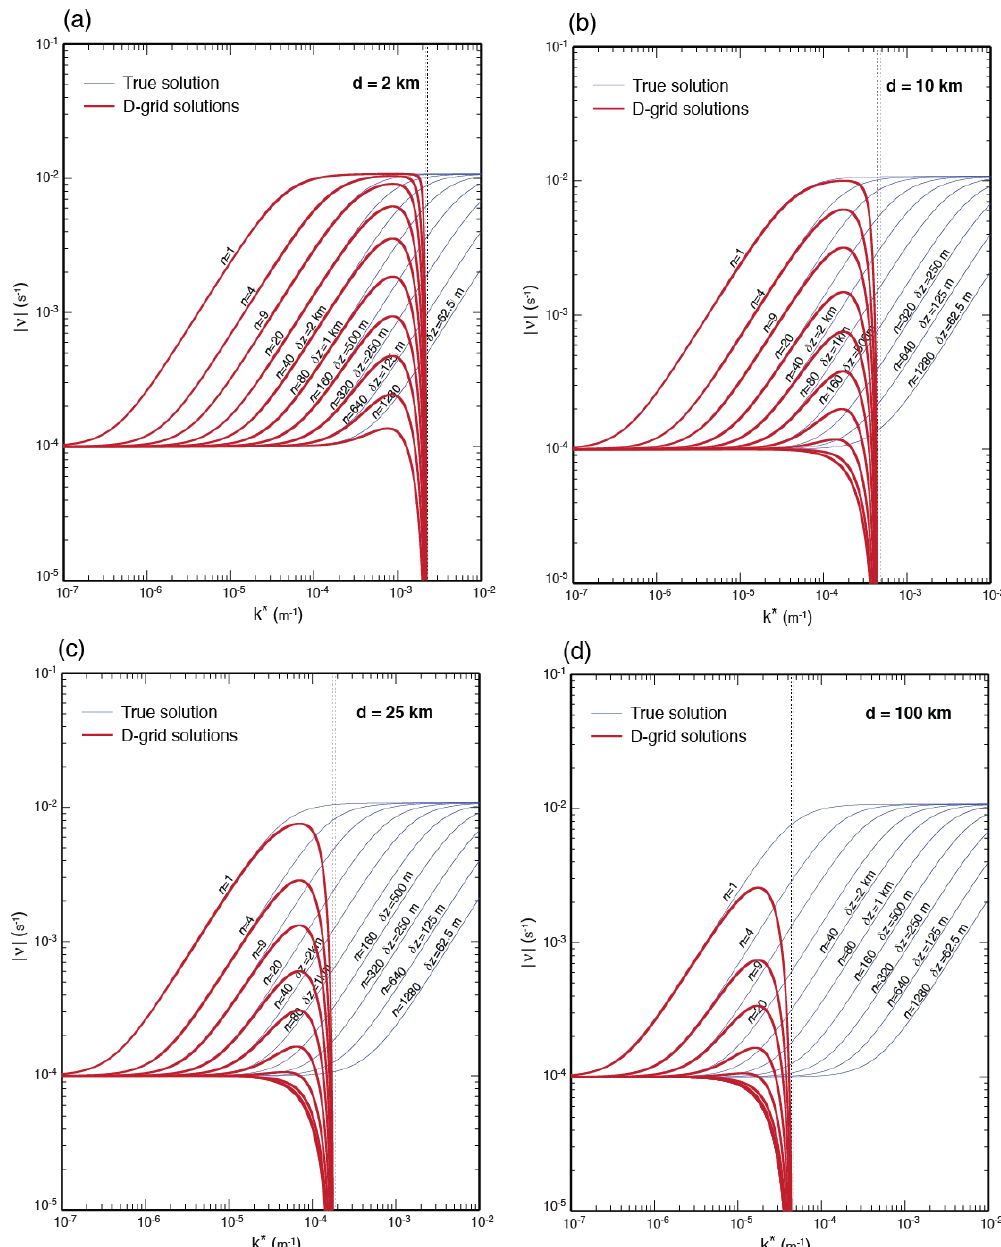
Figure 4. Same as Fig. 2 but for the D